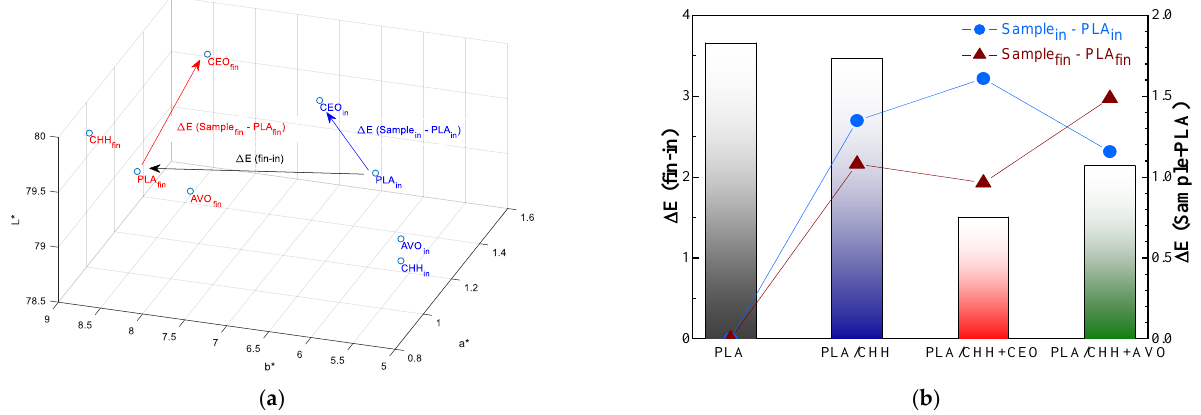
Figure 3. The L*, a*, b* color parameters ( a ) and the color change ( b ) of the coated PLA films before (in) and after (fin) UV irradiation for 30 min at 254 nm.